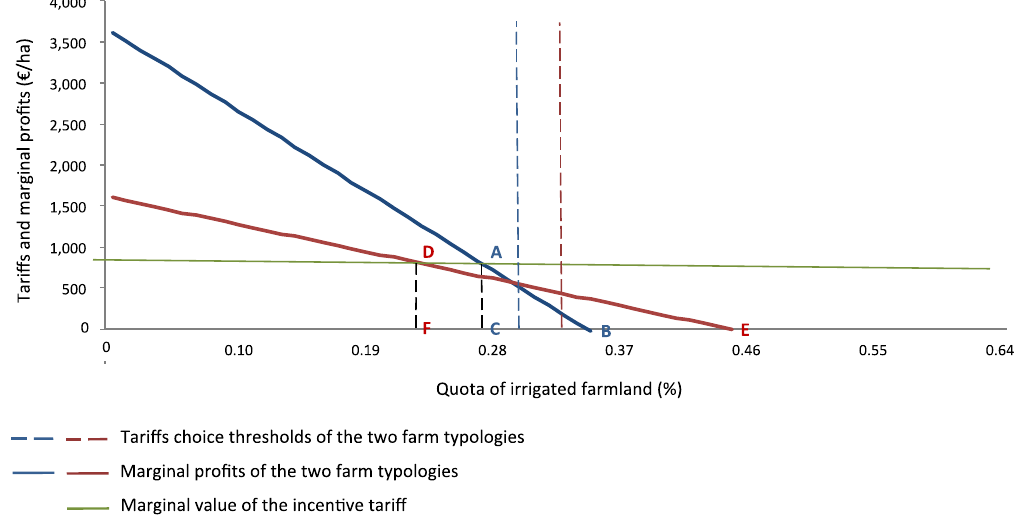
Figure 2. Profit and tariff functions with increasing quotas of irrigated farmland.